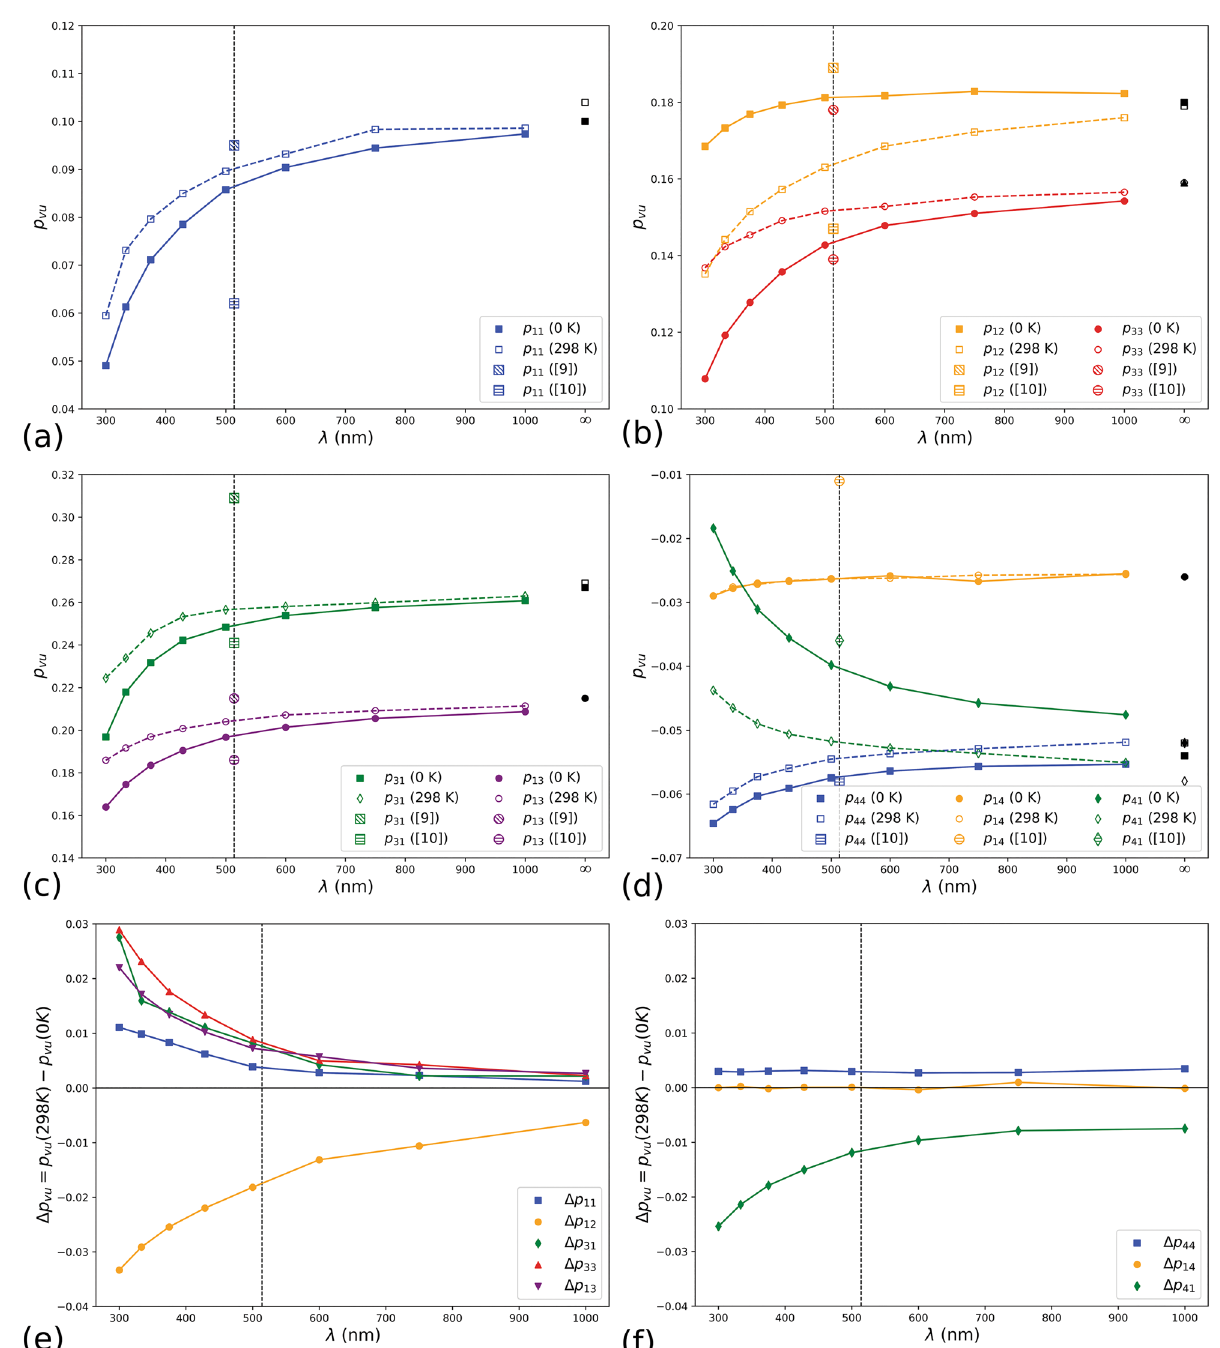
Figure 2. The independent Pöckels’ tensor components of calcite calculated at finite wavelengths λ at the DFT/ PBE-D2 level of theory, ( a ) p 11 , ( b ) p 12 and p 13 , ( c ) p 31 and p 13 and ( d ) p 44 , p 14 , p 41 . The lines connecting the points are meant as a guide for the eye, whereas the dashed vertical line is the λ = 514 nm used in the experiments of Pöckels 9 and Nelson et al. 10 , whose respective data at such wavelength are reported together with the theoretical ones. The black symbols are the photoelastic constants calculated in our simulations in static limit ( λ = ∞). Panels ( e ) and ( f ) report the differences Δ p vu between the calculated room temperature and 0 K photoelastic constants as a function of